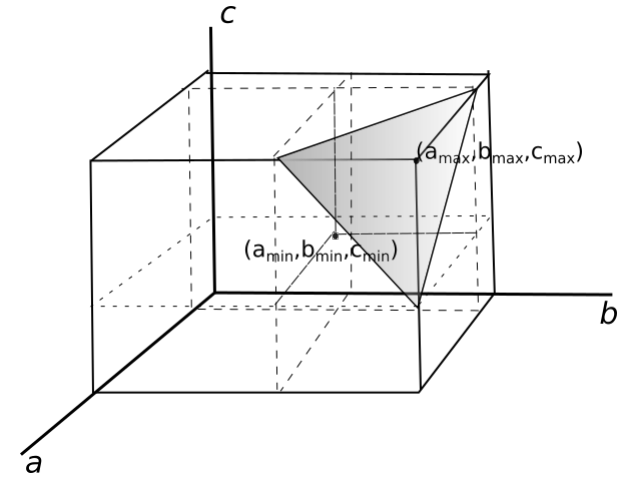
Figure 3 . Solution to the (cid:13) ij